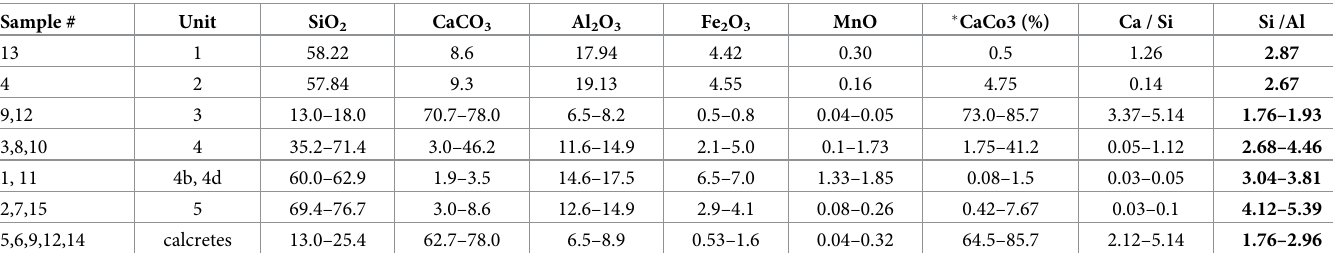
Table 2. Summary of chemical analyses results shown as oxides or carbonates (for Ca), arranged by unit. For full data see S2 and S3 Tables. Sample #